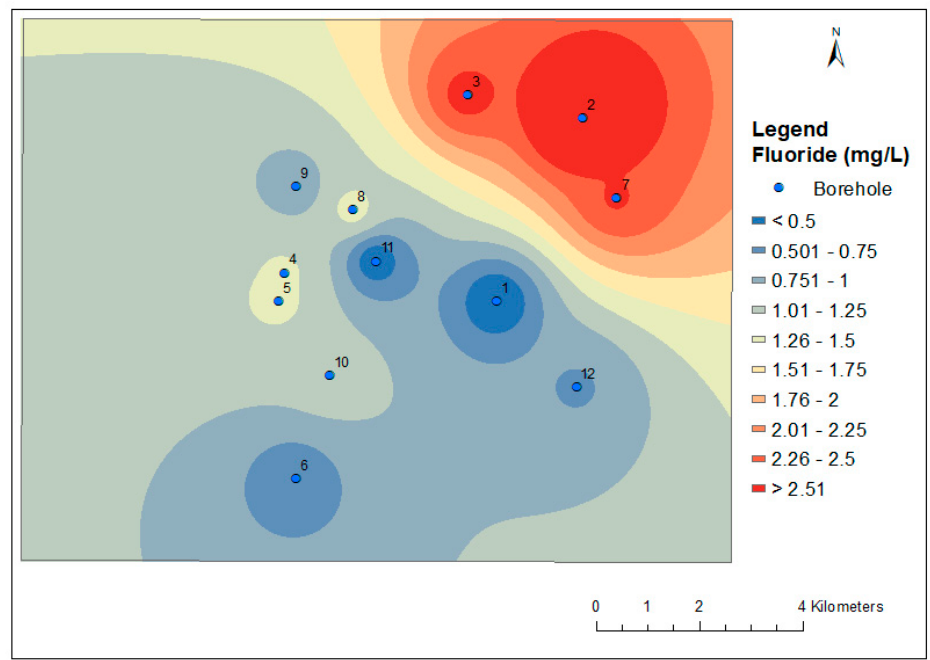
Figure 5. Spatial distribution of sulphate and fluoride using inverse distance weighting (IDW) interpolation in the study area.